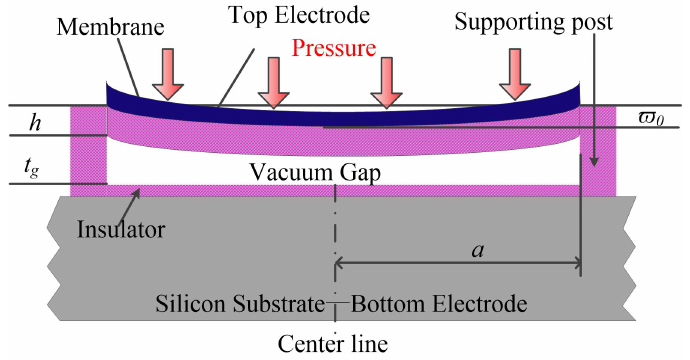
Figure 1. The cross-sectional view of a conventional CMUT with full top electrode. a is the ra- dius of the membrane, h is the membrane thickness and t g is the vacuum gap height, (cid:118) 0 is the center